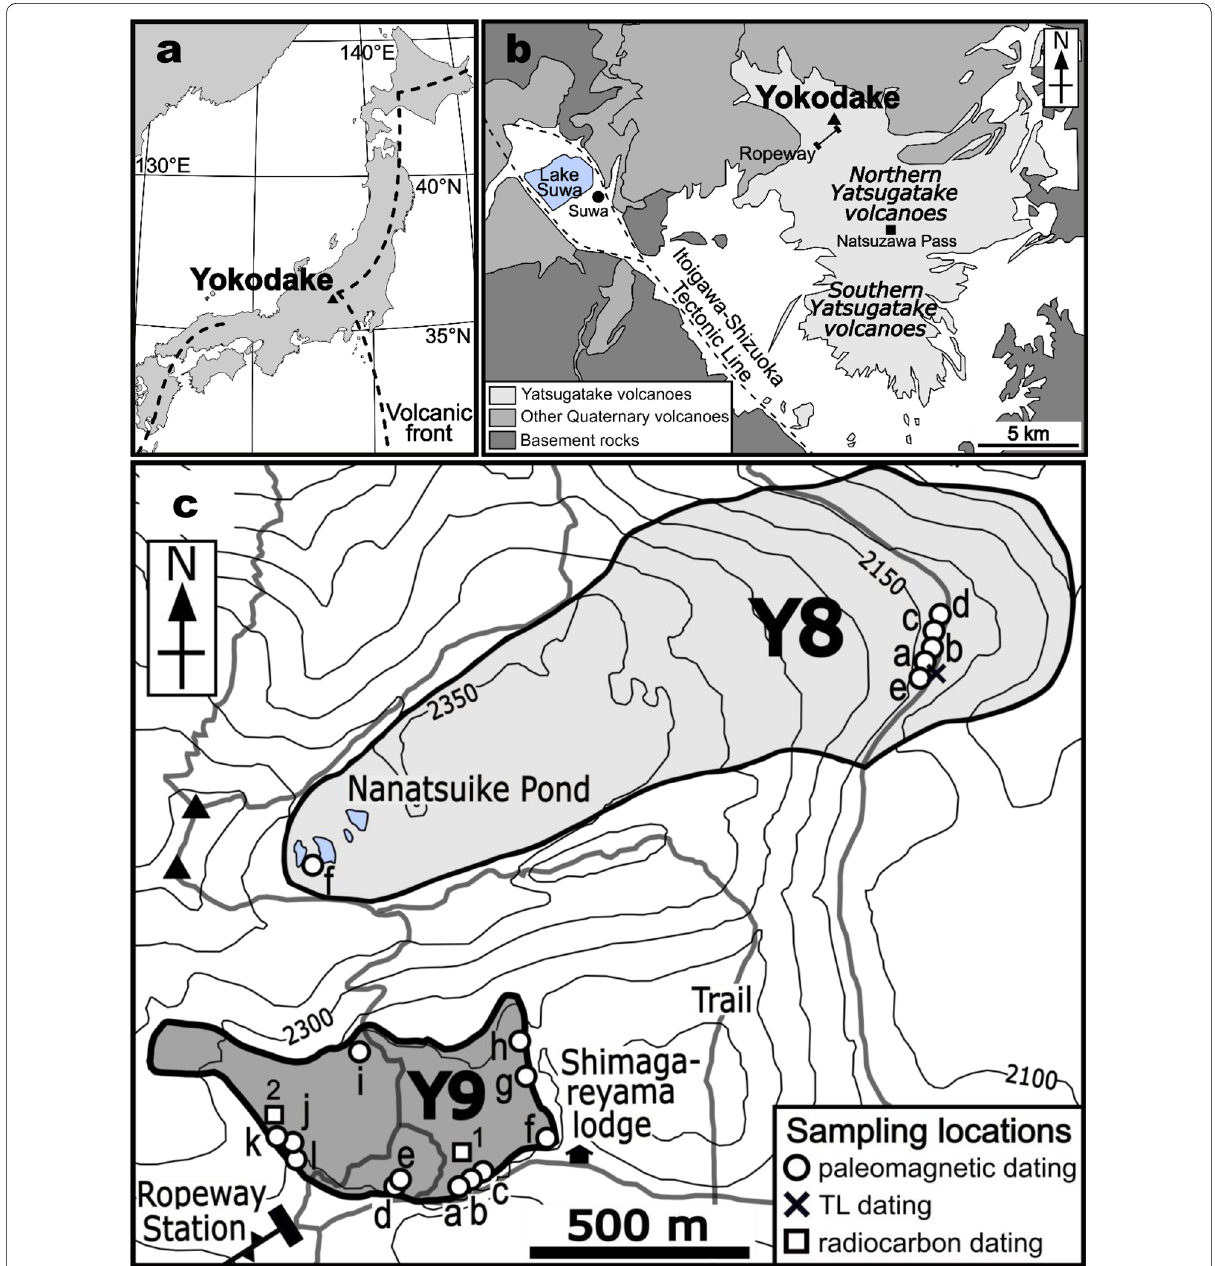
Fig. 1 a Index map of the Japanese islands showing Yokodake volcano. b Simplified geological map around Yatsugatake volcanoes referred from work by Nishiki et al. (2011). c Simplified geological map of the summit area of Yokodake volcano modified from that presented by Kawachi (1974). Distributions of Y8 and Y9 lava are shown. Circles, crosses, and squares, respectively, denote sampling locations for paleomagnetic dating, TL dating, and radiocarbon